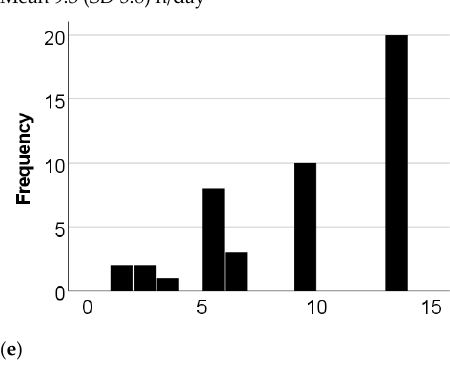
Figure 1. Summary of results on measures of adherence and wearing time. SD, standard deviation; IQR, interquartile range: a The six participants with prefabricated footwear did not answer the questions on subjective wearing time and one participant with fully custom-made footwear had missing answers. The two subjective measures of wearing time had a very strong correlation, r = 0.99 ( p < 0.001). Therefore, we decided to only include the (unweighted) subjective wearing time in the further analyses. Proportion of steps that the prescribed footwear was worn correlated very strongly (r = 0.96, p < 0.001) and objective wearing time correlated very strongly (r = 0.91, p < 0.001) with the reference measure (Figure 2). Subjective wearing time had a moderate correlation with the reference measure (r = 0.42, p = 0.004). Proportion of daily steps footwear was worn correlated strongly with objective wearing time (r = 0.87, p < 0.001) and moderately with subjective wearing time (r = 0.43, p = 0.003). Objective wear- ing time of footwear correlated moderately with subjective wearing time (r = 0.46, p = 0.001).